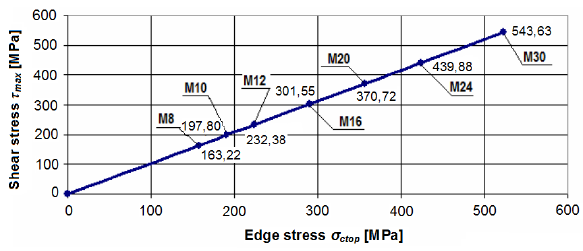
Figure 12: Dependency shear stress – adhesion stress for M8 ÷ M30 anchors in the gable wall.